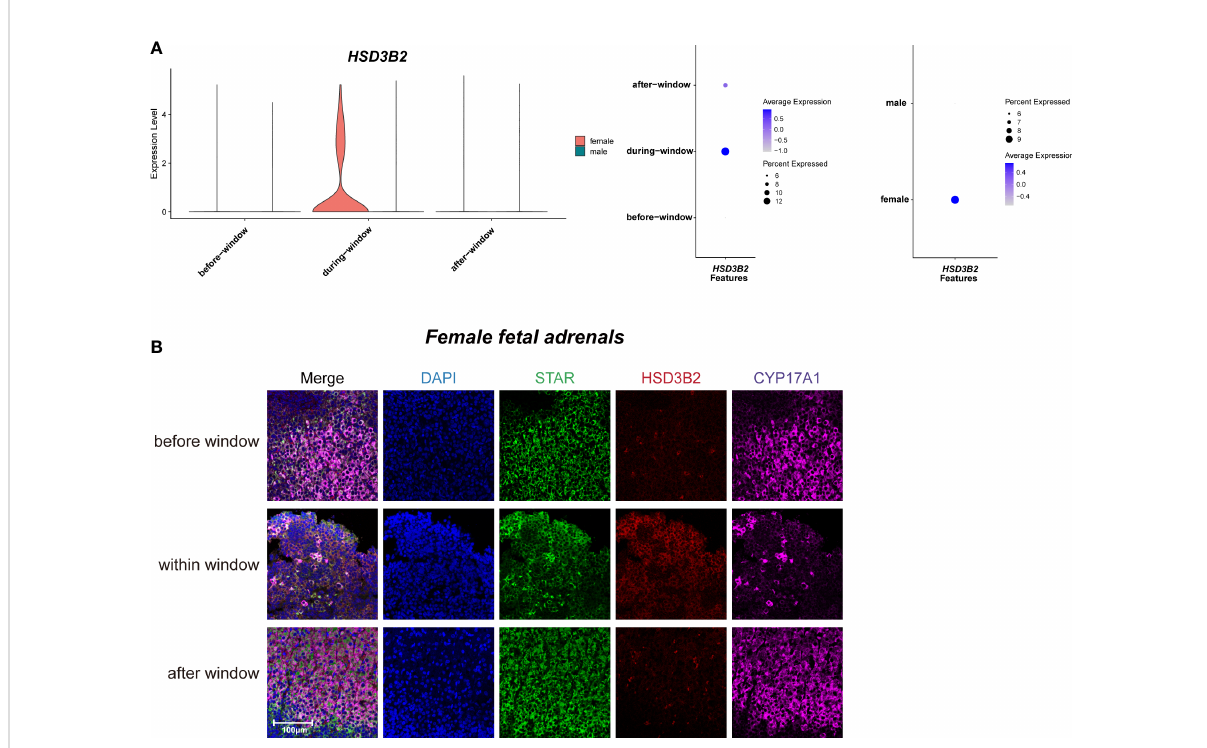
FIGURE 3 Sexual dimorphic expression patterns of steroidogenic-related genes in steroidogenic cells. (A) Violin and dot plots of HSD3B2 gene expression patterns of female and male fetal adrenal steroidogenic cells spanning the window of sexual differentiation. (B) Immuno fl uorescence staining of StAR (green), HSD3B2 (red), and CYP17A1 (purple) in the female fetal adrenal glands spanning the window of sexual differentiation. Scale bar, 20 m m. n =